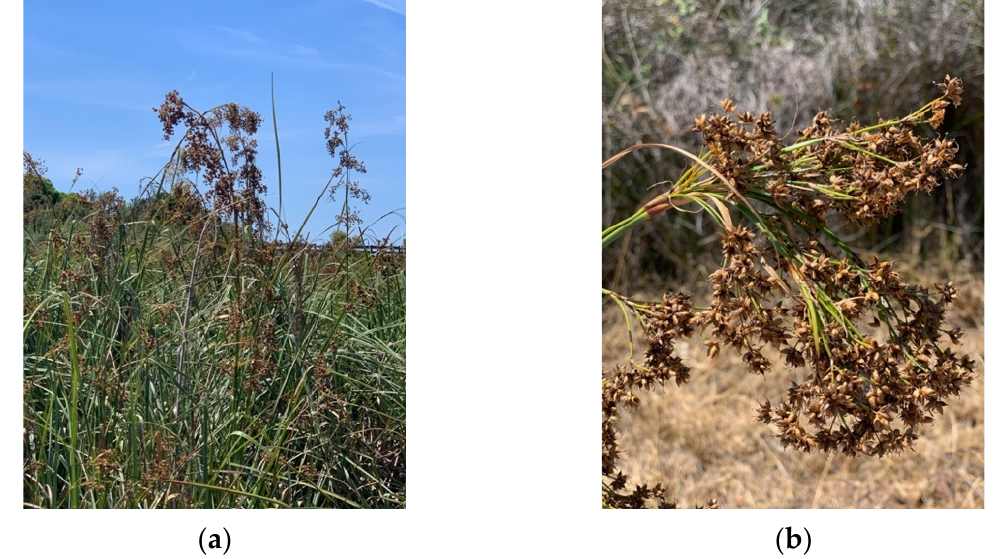
Figure 1. Cladium mariscus (sawgrass) in a saltmarsh of Southern Portugal, in the Ria Formosa Lagoon: ( a ) whole plant; ( b ) seeds. Photos by Marta Oliveira.